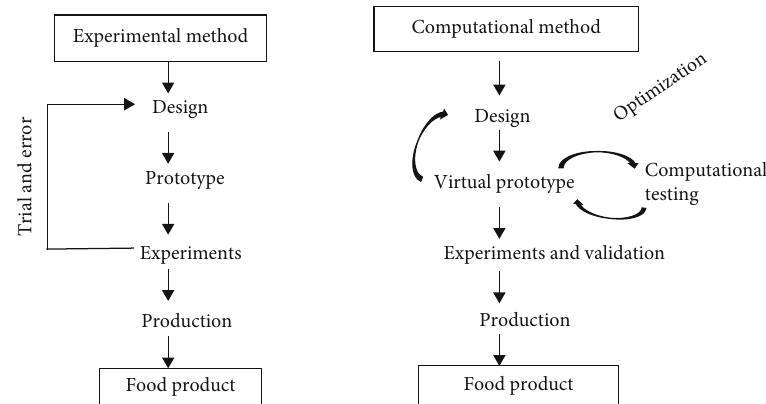
Figure 3: Experimental and computational methods applied to food product [51].